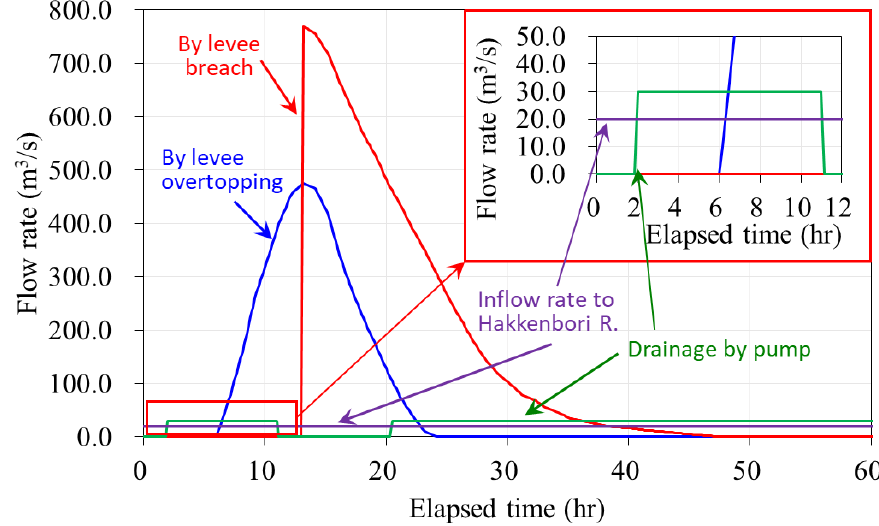
Figure 13. Rate of inflow and outflow for 2015 flood; inset shows magnified view.